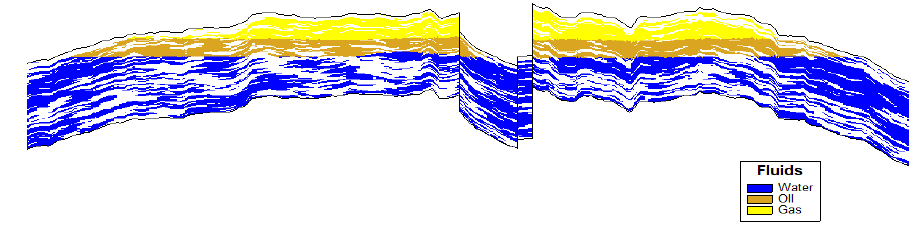
Figure 2. Geological profile of the reservoir (depth 950–1100 m) [19].